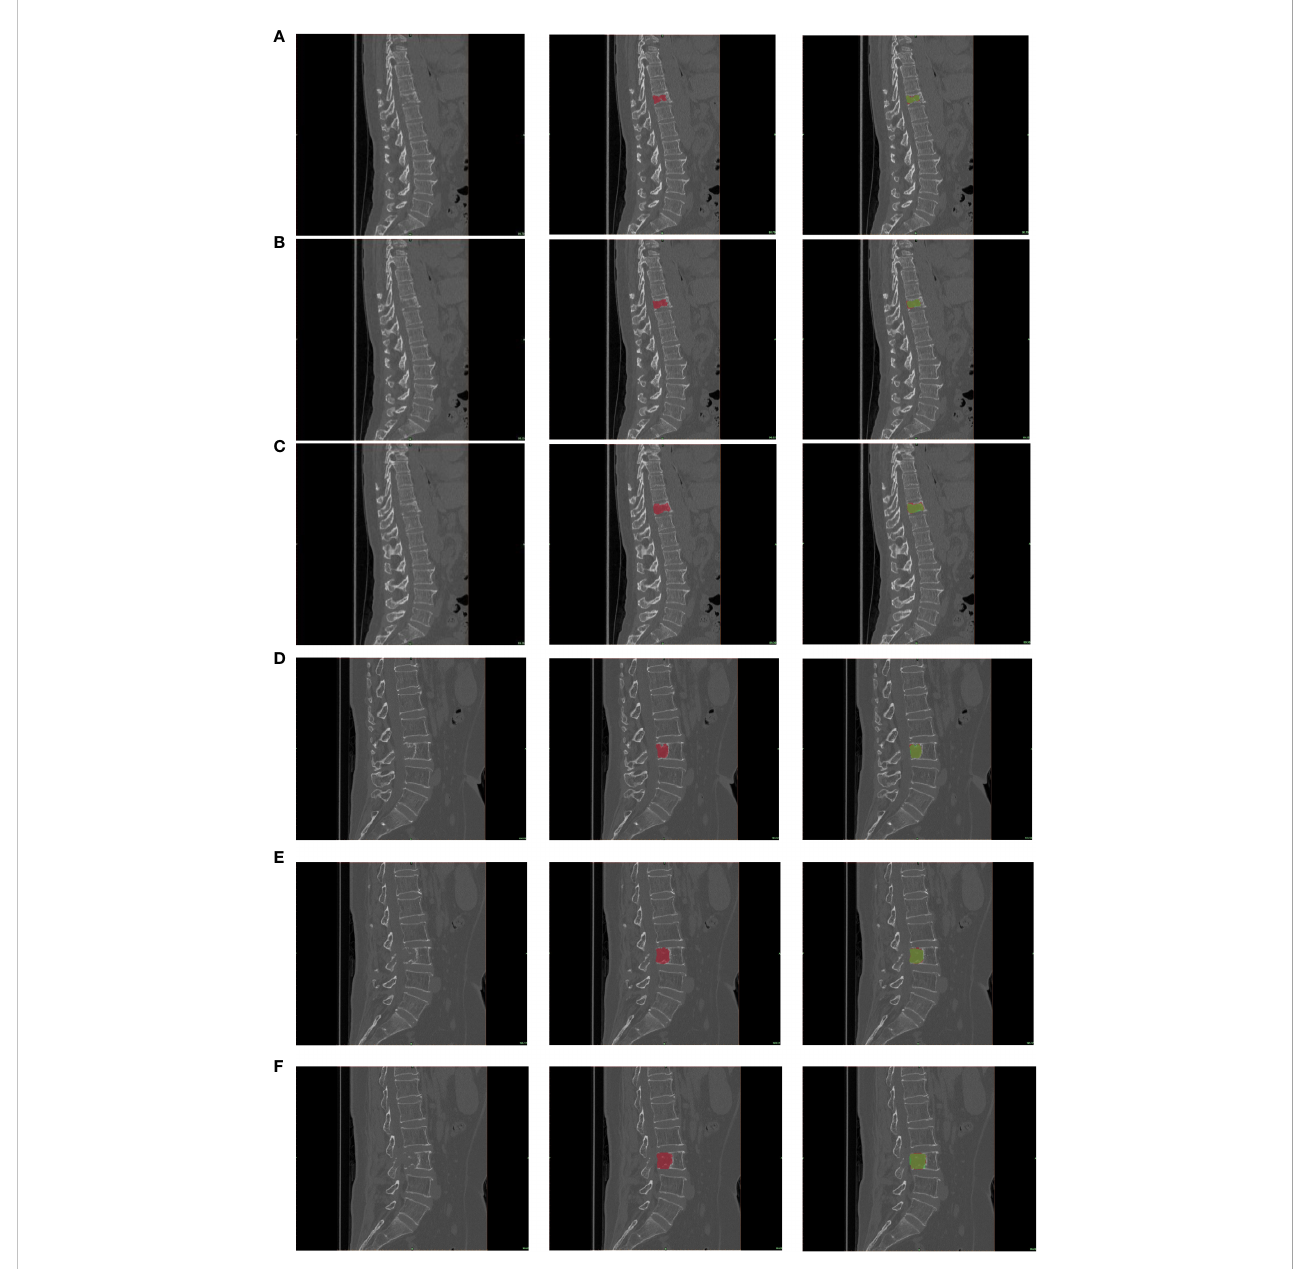
FIGURE 3 The segmentation results. Representative example of a patient with lung cancer bone metastasis with abnormal signals in the 4 lumbar spine (A – C) and a patient with lung cancer bone metastasis with abnormal signals in the 11 thoracic spine (D – F) , and true-positive lesions with various appearances and locations. From left to right, the three images in a row are the original image, the corresponding GT label (red), and the candidate region output from the deep convolutional neural network (DCNN) (green). Note that the green region on the right image is a candidate region with a threshold of 0.5, and dice was calculated on this